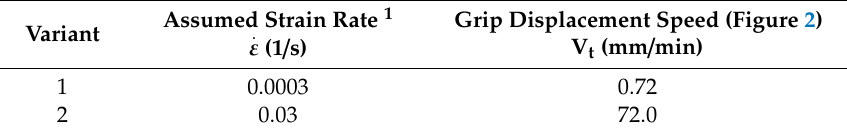
Table 2. Kinematic assumptions for a longitudinal tensile test of PLGA tubular-type